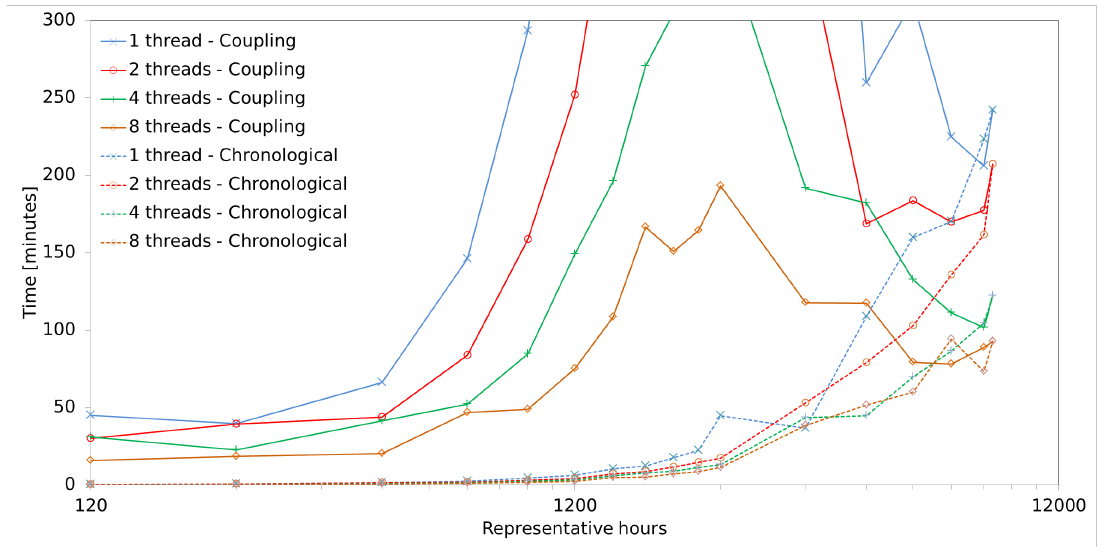
Figure 10. Computational time for the coupling and chronological method using 1, 2, 4, and 8 CPU